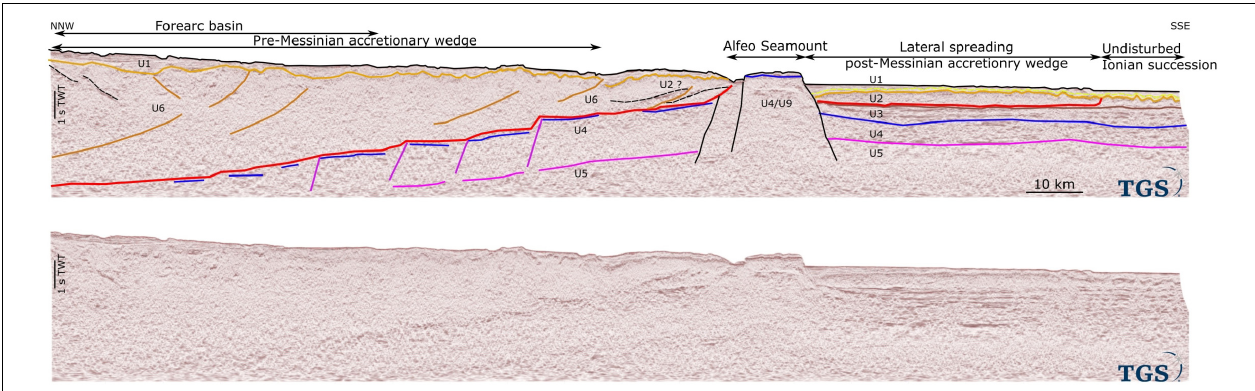
FIGURE 3 | Seismic reflection profile across the Calabrian accretionary wedge, the Alfeo seamount and the outer post-Messinian accretionary wedge. See Figure 2A for location. The data presented here are subject to a confidentiality agreement with TGS that does not allow us to show the absolute two-way-time on the seismic